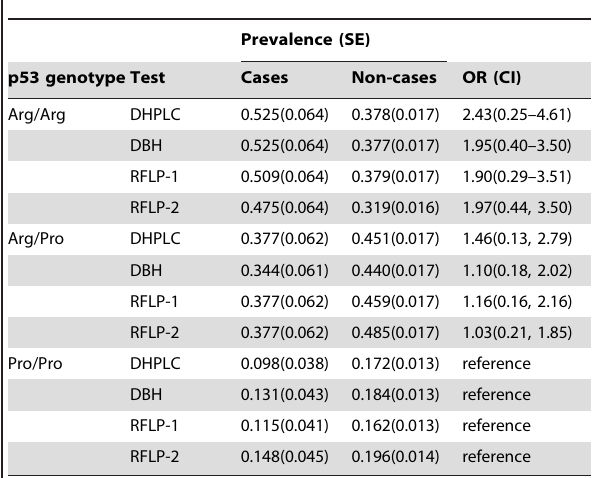
Table 5. Prevalence (standard error) of p53 genotypes in case and non-case groups, and empirical ORs, for four laboratory tests.